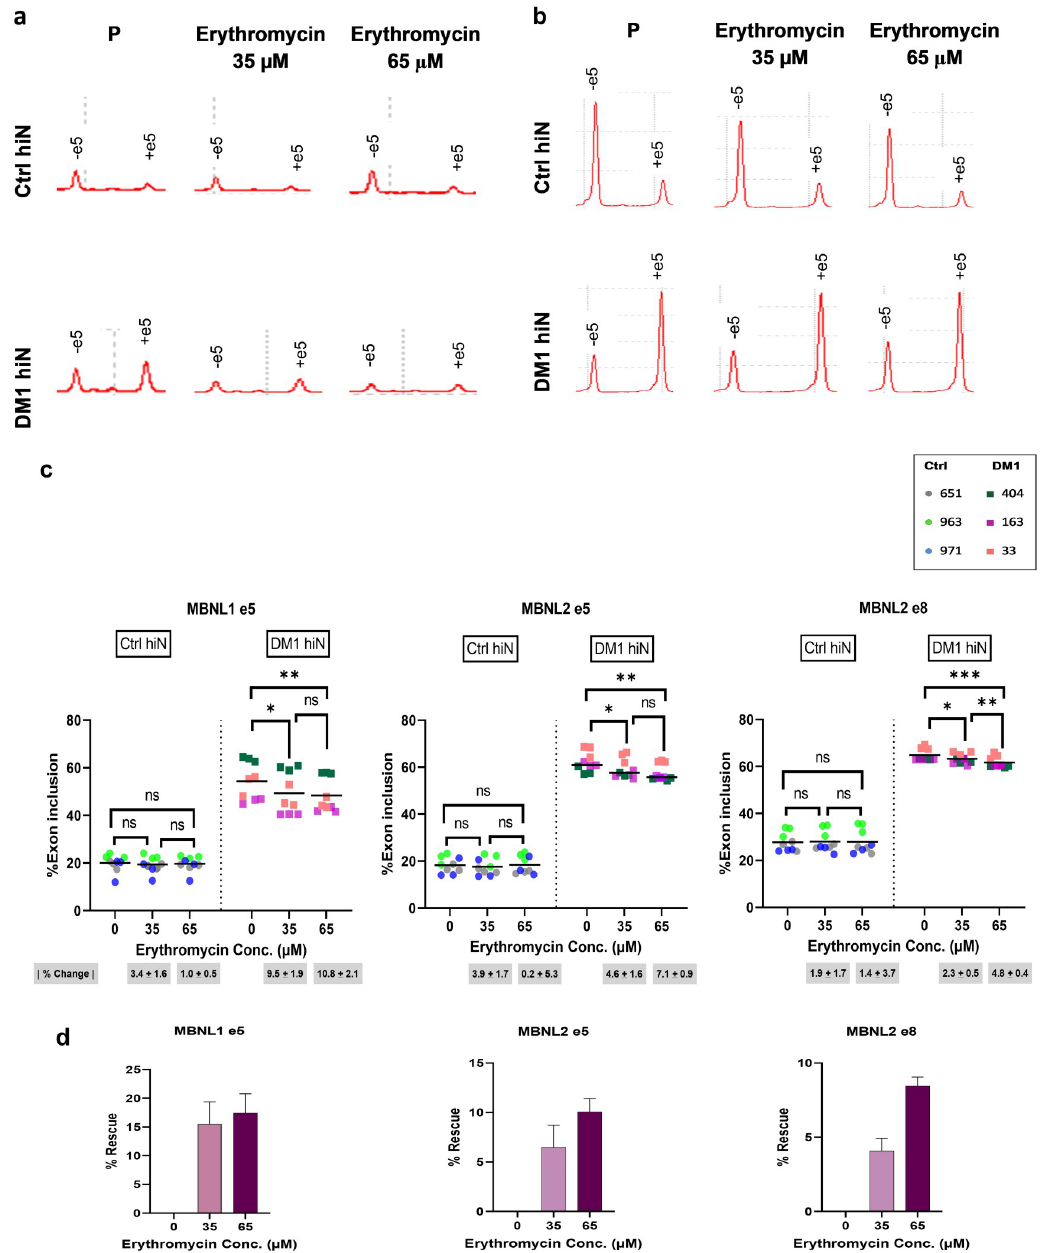
Fig 6. Rescue of MBNL 1 e5 and MBNL 2 e5 and e8 mis-splicing by erythromycin lactobionate treatment at 10 DPI. (a-b) Electropherograms plot the results of RT-PCR products for MBNL 1 e5 (a) and MBNL 2 e5 (b) in ctrl (top) and DM1 hiNeurons (bottom). Note the decreased inclusion of MBNL 1 e5 (+e5) and MBNL 2 e5 (+e5) in DM1 hiNeurons treated with 35 or 65 μ M erythromycin for 48 h relative to placebo treated cells. RT-PCR products were analyzed by MultiNA automated microchip electrophoresis system. (c) Scatter plots show inclusion percentage of MBNL 1 e5 (left), MBNL 2 e5 (middle) and MBNL 2 e8 (right) in control and DM1 hiNeurons treated with placebo or erythromycin. n = 3 for each group. Each sample is presented in different color. Each symbol represents percentage of exon inclusion for one sample replicate. Line represents mean. � P < 0.05, �� P < 0.01, ��� P < 0.001 and ns, not significant compared by repeated measures one-way ANOVA test. Erythromycin treatment had no adverse effects on control group. Absolute values of mean change percentage |% change| ± SEM relative to placebo treated cells in each group are indicated below the graphs. (d) Bar graphs show rescue percentage of aberrant splicing of MBNL 1 e5 (left), MBNL 2 e5 (middle) and MBNL 2 e8 (right) in DM1 hiNeurons by erythromycin treatment. Data are presented as mean ± SEM. P, placebo (same amount of diluent without drug).